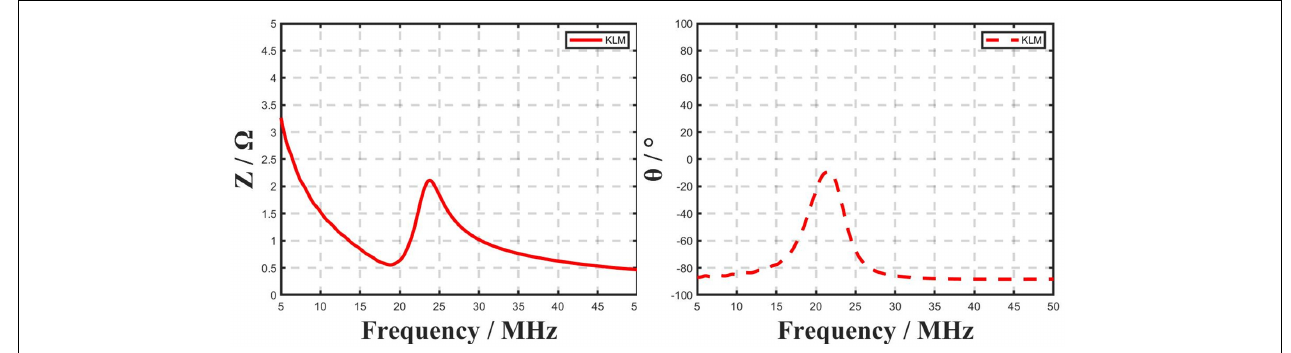
FIGURE 10 | The amplitude and phase of 20M transducer by using PiezoCAD.